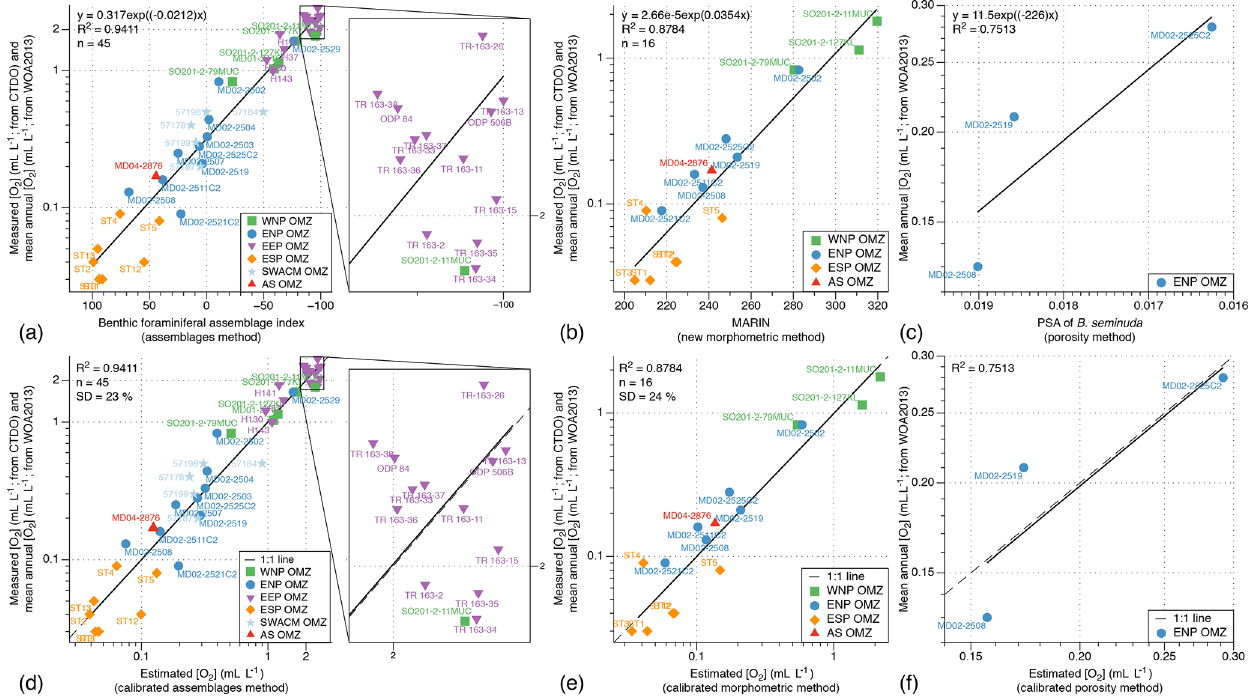
Figure 3. (a–c) Relationship between the bottom water oxygenation and the benthic foraminiferal index, the new morphometric index (MARIN), and the porosity of B. seminuda . (d–f) Relationship between the bottom water oxygenation and the calibrated assemblage method estimation, taxon-independent morphometric method estimation, and porosity method